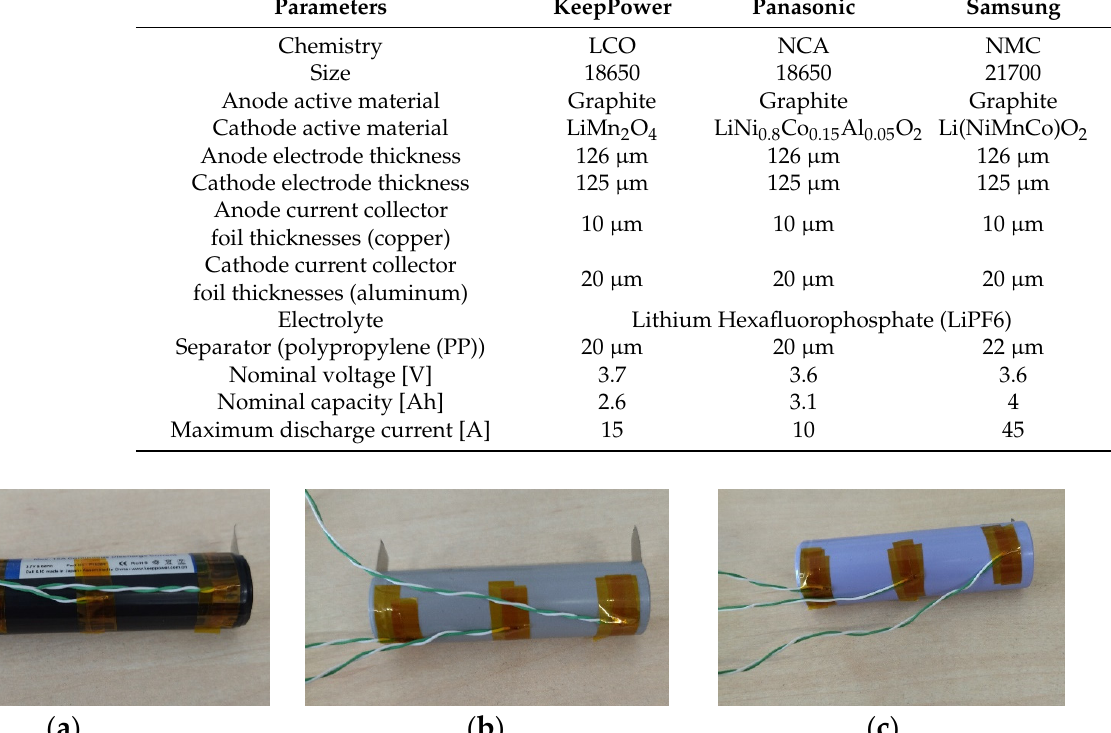
Figure 2. Positioning of thermocouples on the battery surface: ( a ) LCO; ( b ) NCA; ( c ) NMC.